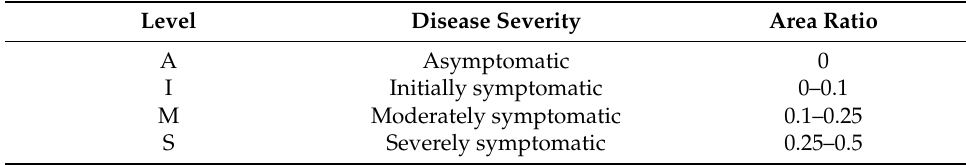
Table 1. Disease severity levels at leaf scale. Level Disease Severity Area Ratio A Asymptomatic 0 I Initially symptomatic 0–0.1 M Moderately symptomatic 0.1–0.25 S Severely symptomatic